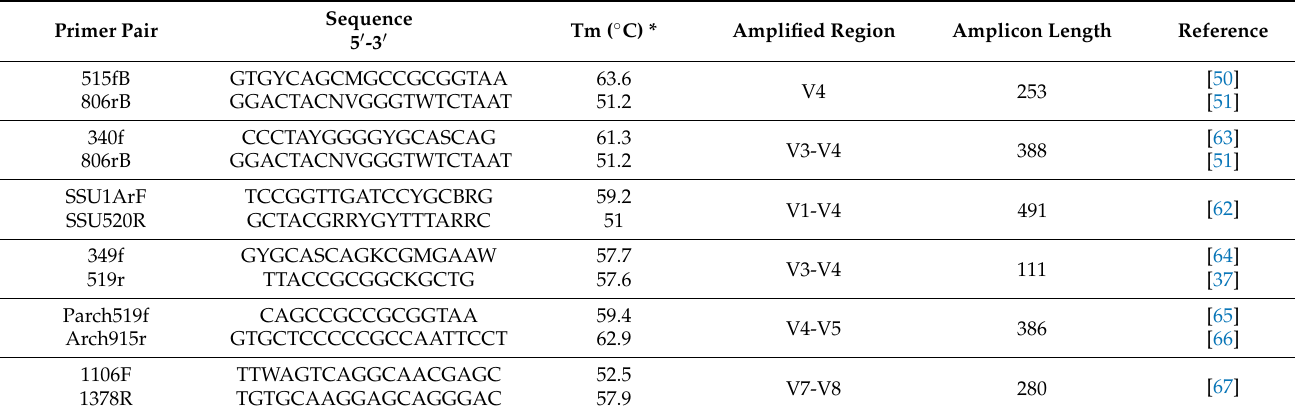
Table 3. Primer pairs targeting the 16S rRNA gene that have been frequently used to characterize Archaea biodiversity in studies based on Illumina